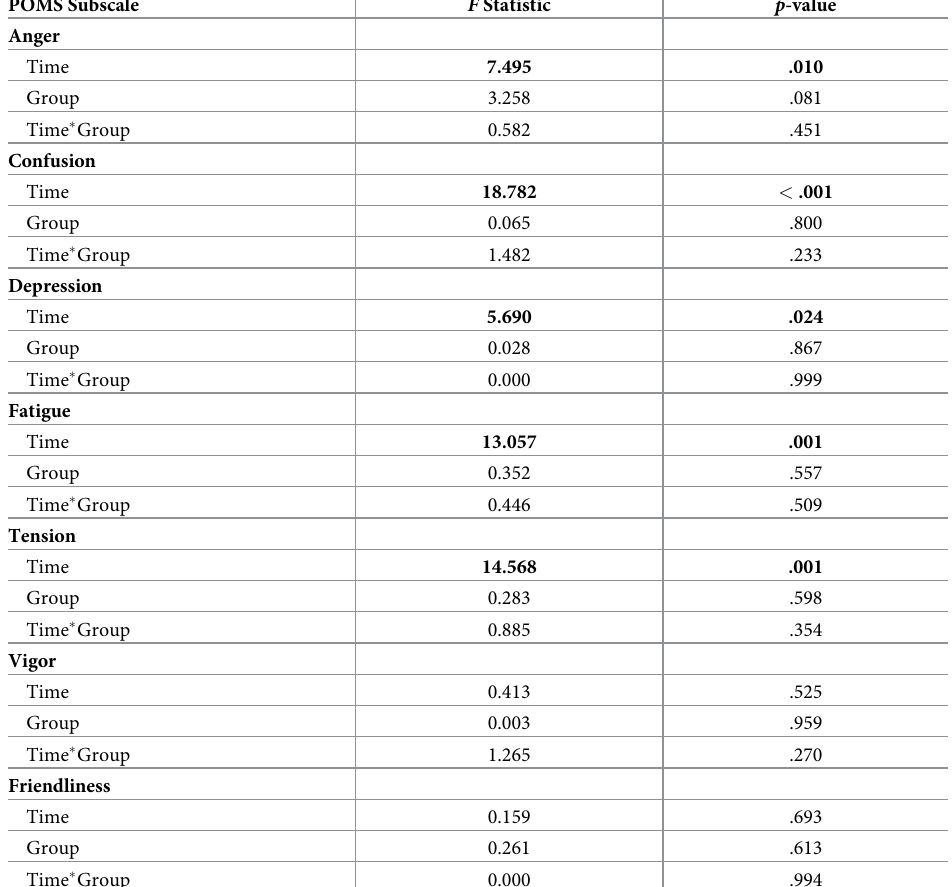
Table 7. POMS subscales F -Test table from a two-way repeated measures ANOVA with Bonferroni correction for comparisons within each subscale